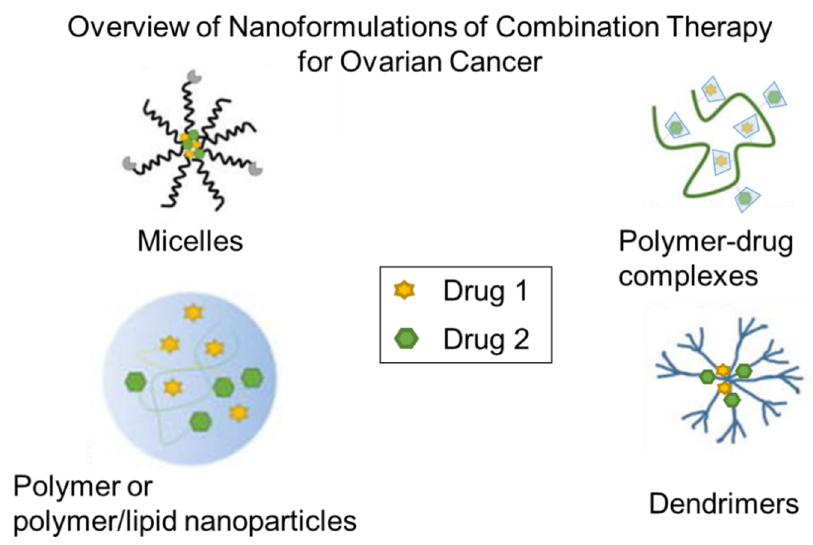
Figure 4. Schematic overview of the polymer-based nanocarriers used for combination therapy in ovarian cancer included in this review.